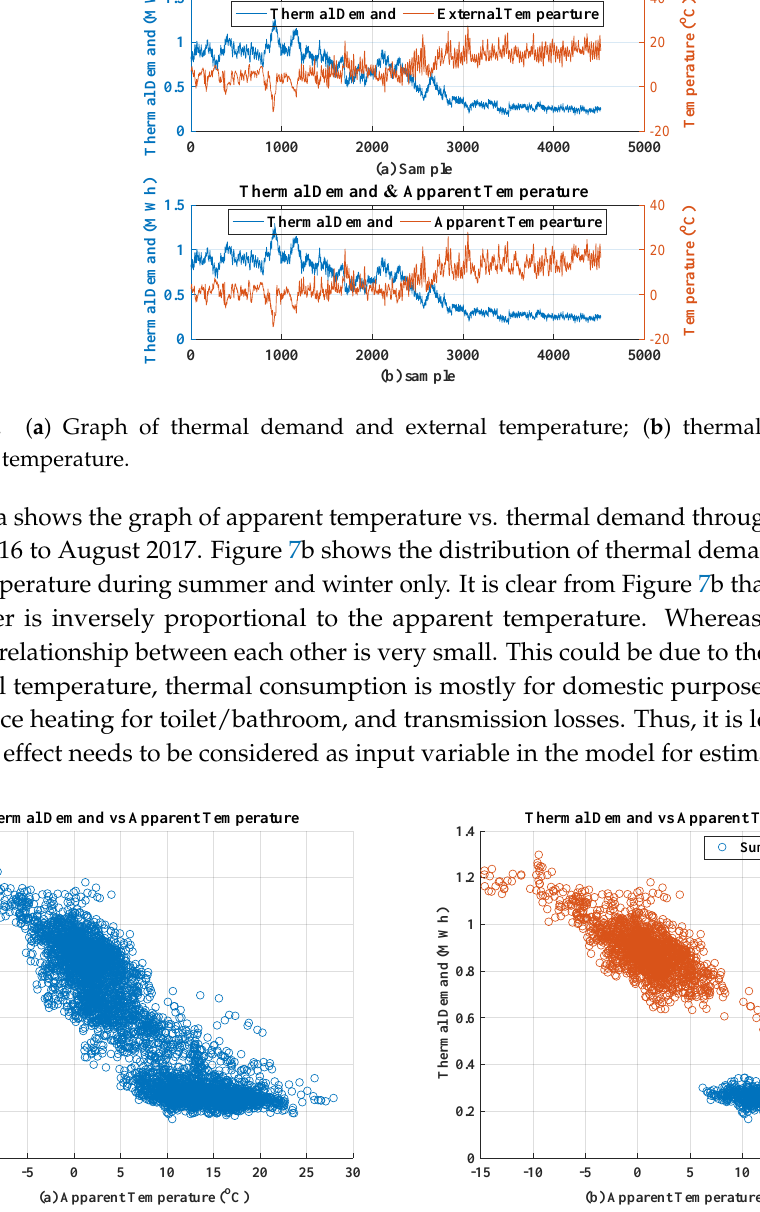
Figure 7. ( a ) Thermal demand vs. apparent temperature throughout the period. ( b ) Thermal demand vs. apparent temperature during winter and